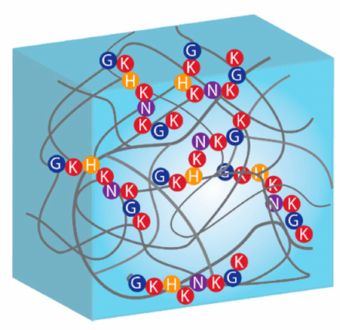
Scheme 4. Schematic representation of peptide-functionalized hybrid